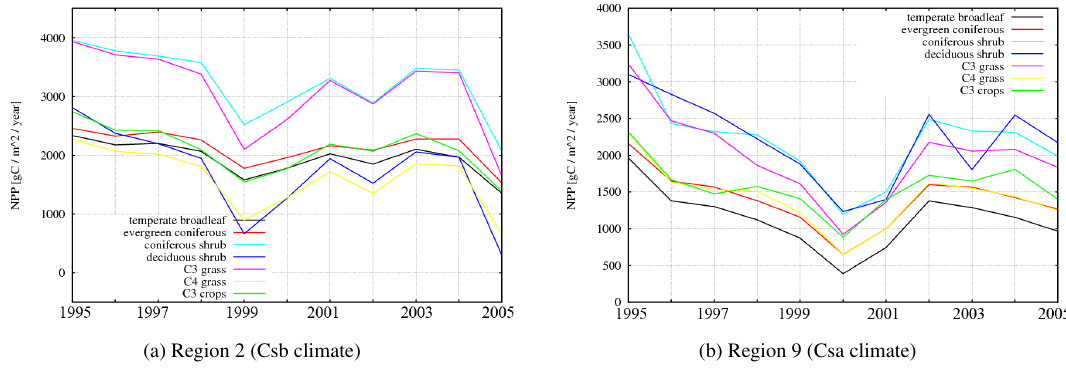
Fig. 12. Net primary productivity [ gCm − 2 a − 1 FM] variations in evaluation region 2 and 9 in the period 1995 Figure 12. Net primary productivity [gCm − 2 a − 1 FM] variations in evaluation region 2 and 9 in the period 1995 to 2005.